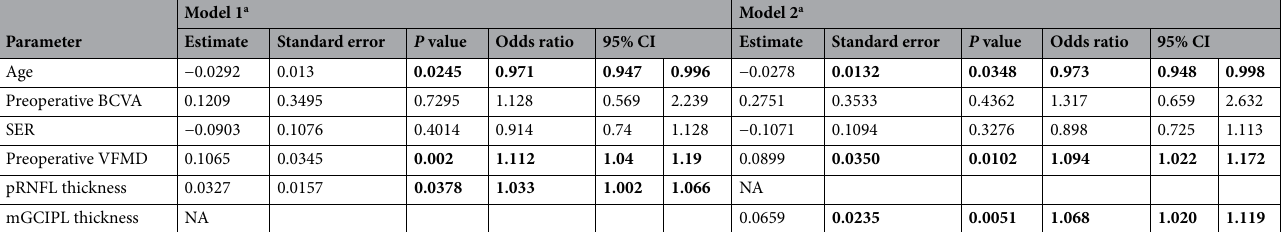
Table 2. Multivariable logistic regression analysis of complete recovery. Significant values are indicated in bold. BCVA best-corrected visual acuity, CI confidence interval, SER spherical equivalent refractive errors,